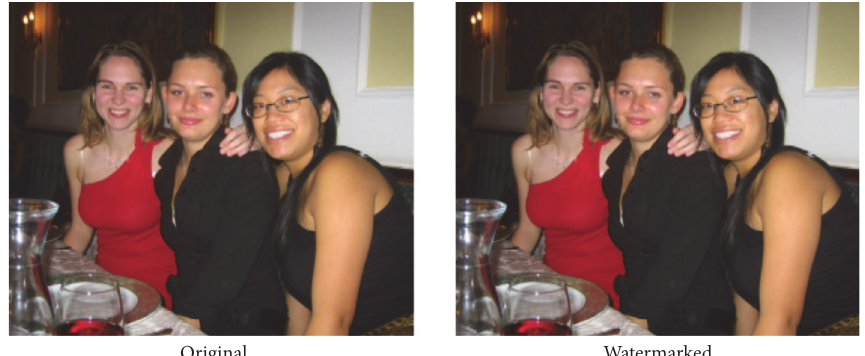
Figure 4: Comparison of an unwatermarked and a watermarked image with embedding strength of 60 %.